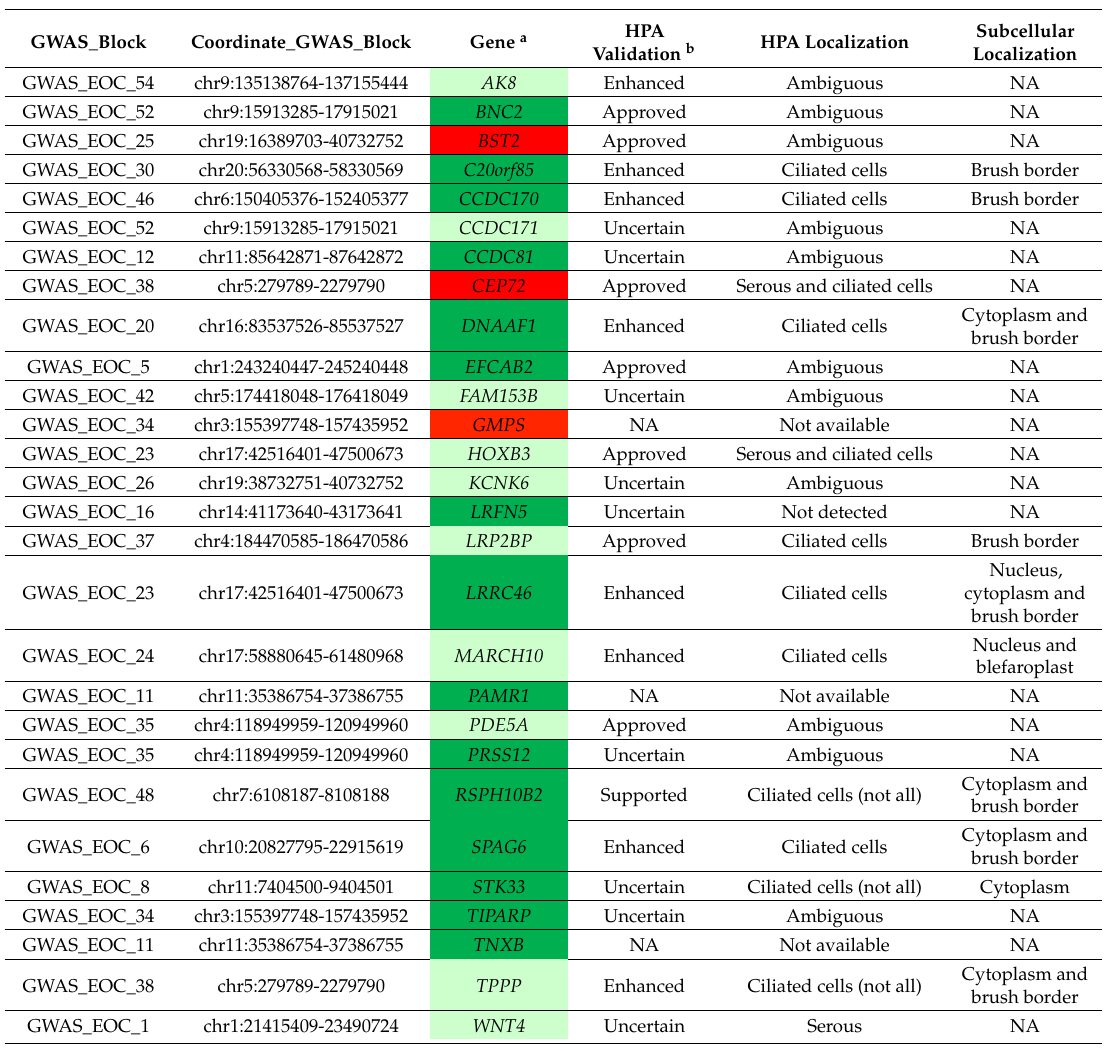
a Colors indicate whether gene expressions are increased (green) or decreased (red) in one (light-green or red) or in two (dark-green or red) gene expression datasets (GSE69428 and GSE10971) by comparing high-grade serous epithelial ovarian cancers (HGSOC) and micro-dissected fallopian tube epithelia. b According to the Human Protein Atlas (HPA) antibody tissue validation. Supported: consistency with RNA sequencing (RNA-seq)